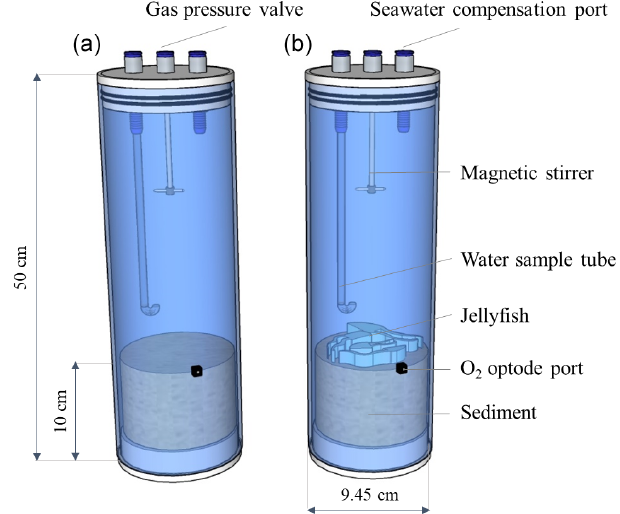
Figure 2. Experimental setup. Incubation cylinders including jelly- fish treatment ( a , N = 3) and controls ( b , N =